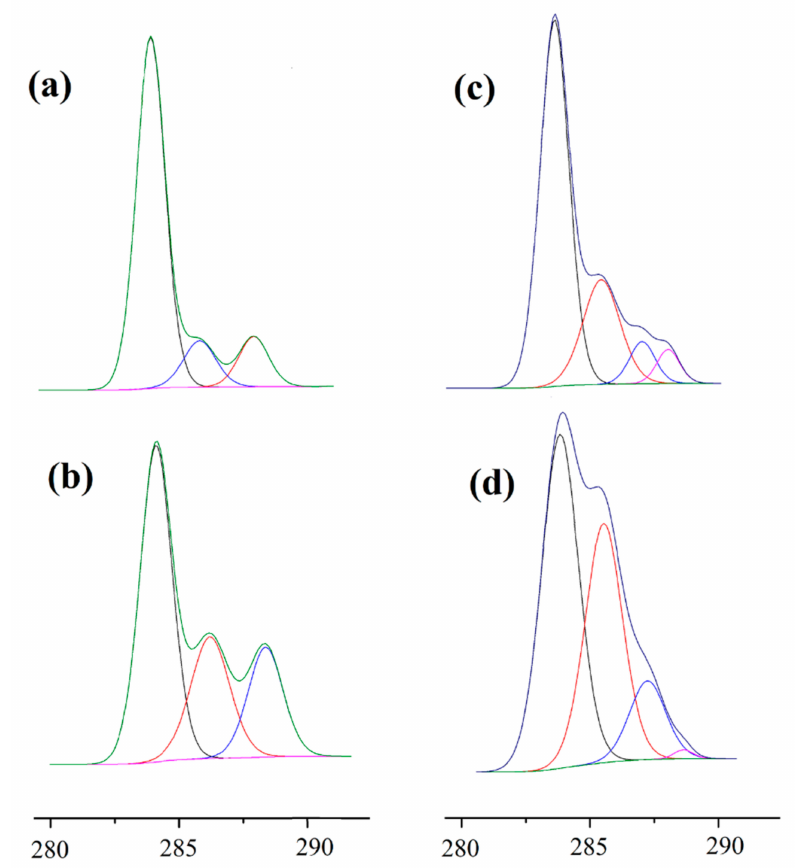
Figure 4. XPS C1s spectra of ( a ) untreated PLA, ( b ) RF, ( c ) g -CS, ( d ) g -CS-ChS.